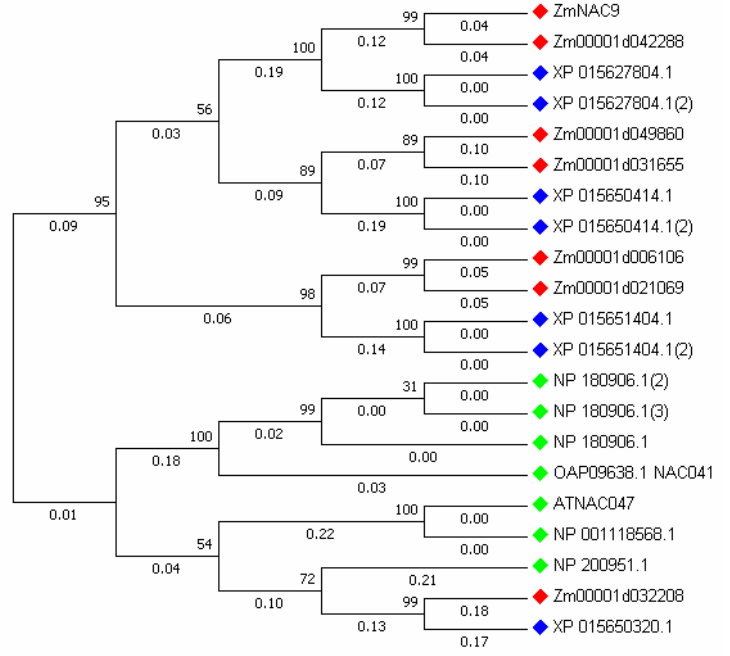
Figure 1. The phylogenetic tree of ZmNAC9 and their homologous genes. Red mark indicates the homologous ZmNAC9 ; blue—rice genes and green— Arabidopsis thaliana .